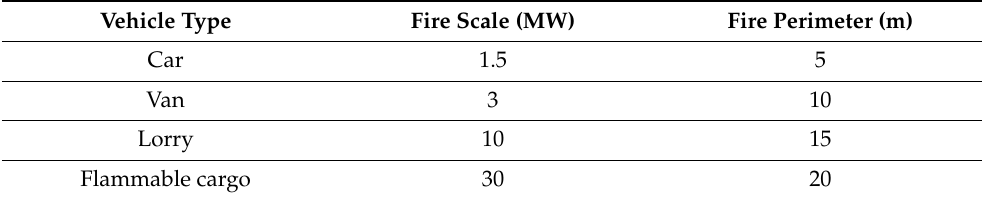
Table 2. Fire size, fire perimeter and smoke generation rate for different vehicles.